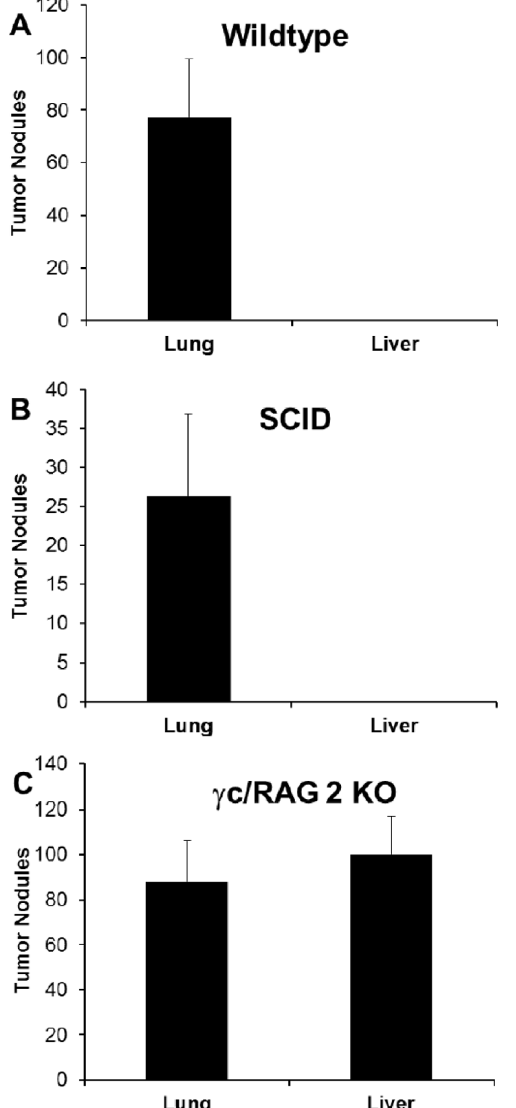
Figure 3. Cytolytic machinery but not IFN-gamma mediates protection from liver tumor colonization. (A) Perforin KO mice or wild-type B6 were injected with 3 6 10 5 B16F1 i.v. and euthanized 12 days later. The difference in tumor nodules in lungs was not significant while the difference in liver nodules was highly significant (p=0.004). (B) IFN- c /IL-12 KO or wild-type B6 mice were injected with B16F1 i.v. and euthanized 12 days later. The differences were not significant (C) Ly49A Tg or wild-type littermate control mice were injected with B16F1 i.v. and euthanized 12 days later. The number of pulmonary tumor nodules was significantly increased in Ly49A Tg mice as compared to WT (p=0.018). The design of the experiments was such that all groups in each panel were examined